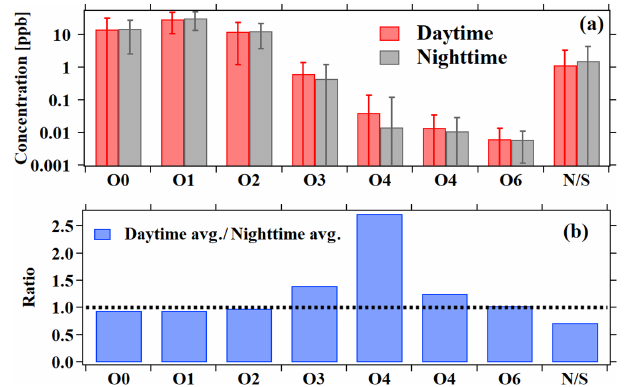
Figure 6. Average mixing ratios for the different groups of ions measured by PTR-ToF-MS. Nighttime (18:00–06:00) averages are shown in black and daytime (06:00–18:00) averages in red, with the error bars indicating the standard deviations. The ratios between daytime and nighttime averages are shown in the lower panel in